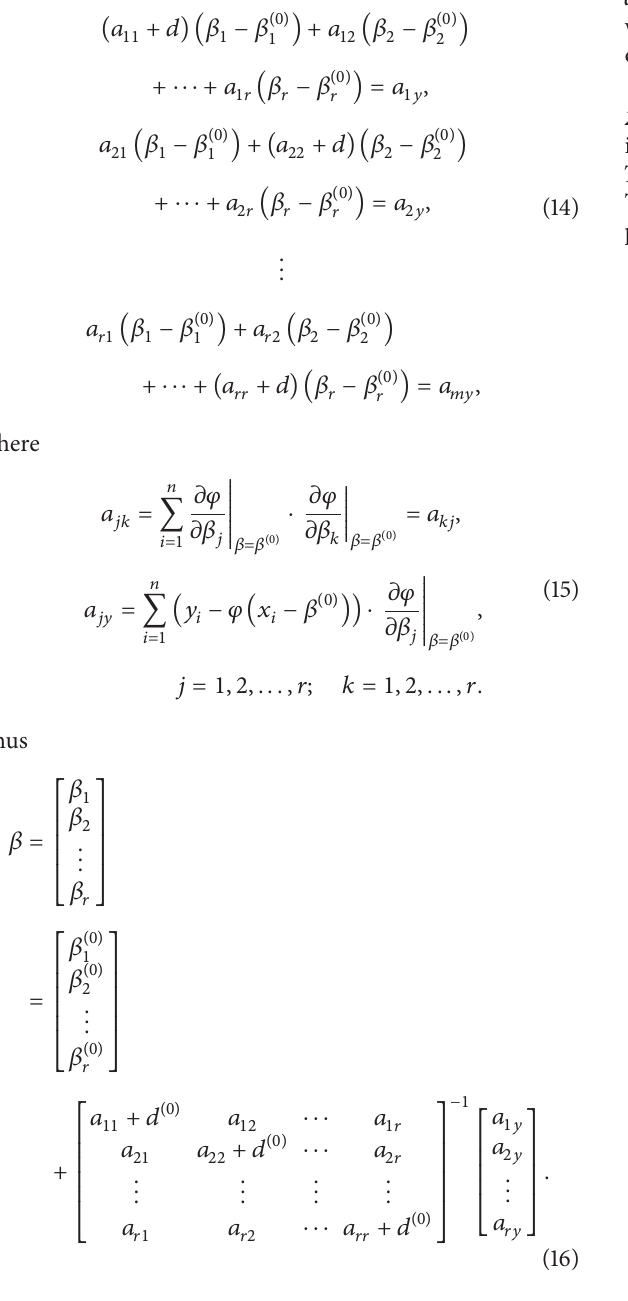
initial values of the parameters according to the aging